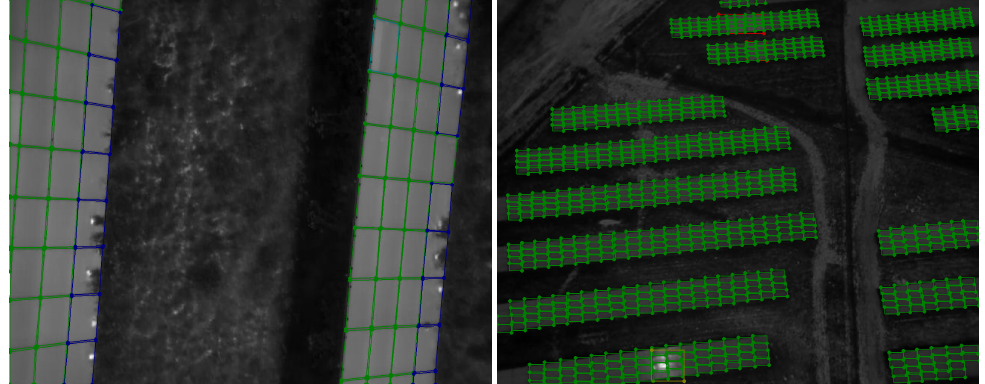
Figure 13. Two kinds of image labeling: on the left , an exact segmentation made with Thermal Studio [45]; on the right , the easier bounding box labeling made with labelme